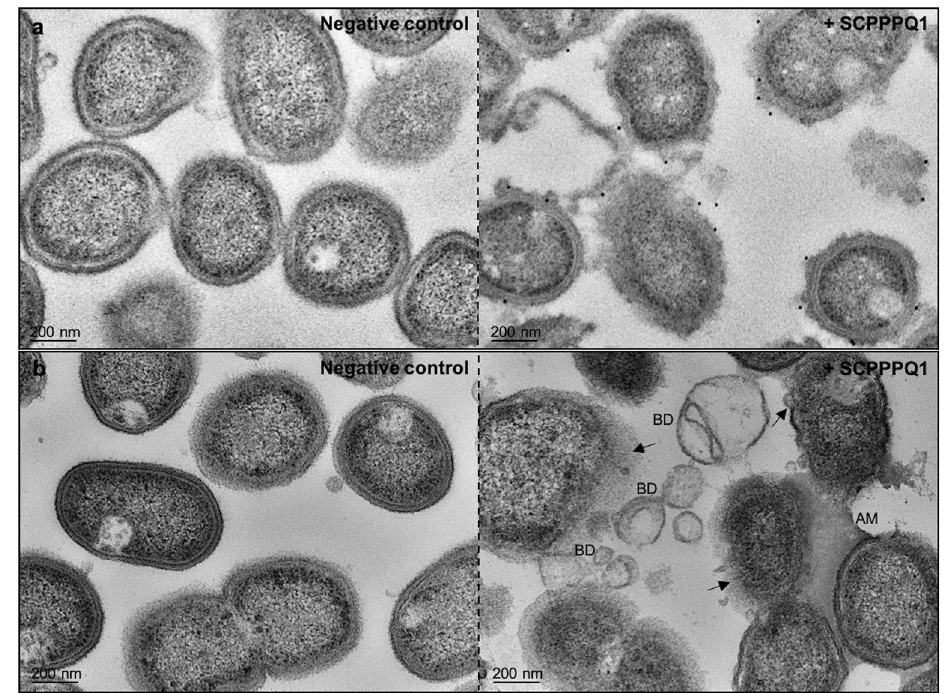
Figure 7. Localisation and effect of SCPPPQ1 on P. gingivalis bacteria using TEM imaging. ( a ) TEM micrographs of pre-embedded immunogold preparations of bacteria from negative control (left) and + SCPPPQ1 treated (right) samples at 20 min. No or very few gold particles (black dots) are present in the negative control while particles are associated with the bacterial surface in + SCPPPQ1 samples. ( b ) TEM micrographs of bacteria sections from the negative control (left) and + SCPPPQ1 treated (right) samples at 20 min. Following treatment with + SCPPPQ1, alteration of bacterial membrane (arrows), bacterial debris (BD) and aggregated material (AM) can be visualized. Micrographs are representative from three different